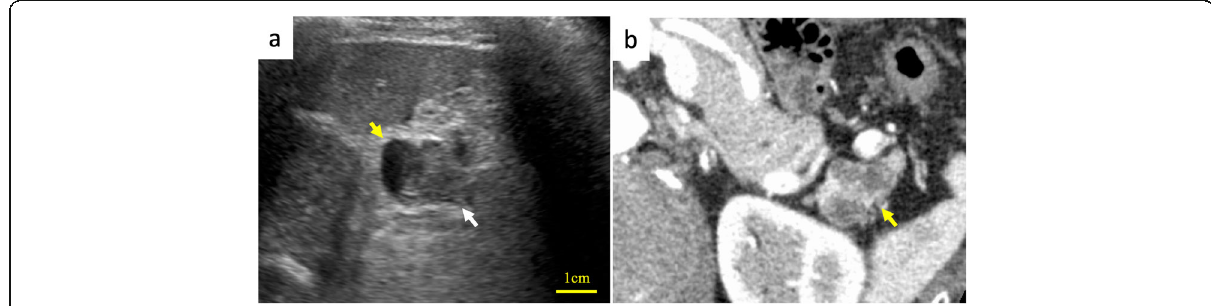
Fig. 1 a Abdominal ultrasound showing a cystic lesion in the pancreatic tail (yellow arrow) and a slightly hyperechoic component (white arrow) in the cystic lesion. b Contrast-enhanced abdominal computed tomography shows a cystic mass with a diameter of 24 mm (yellow